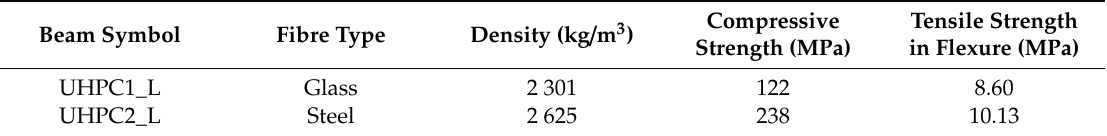
Figure 2. Geometry of the analysed beams (dimensions in mm). Table 1. Basic mechanical properties of the beams.